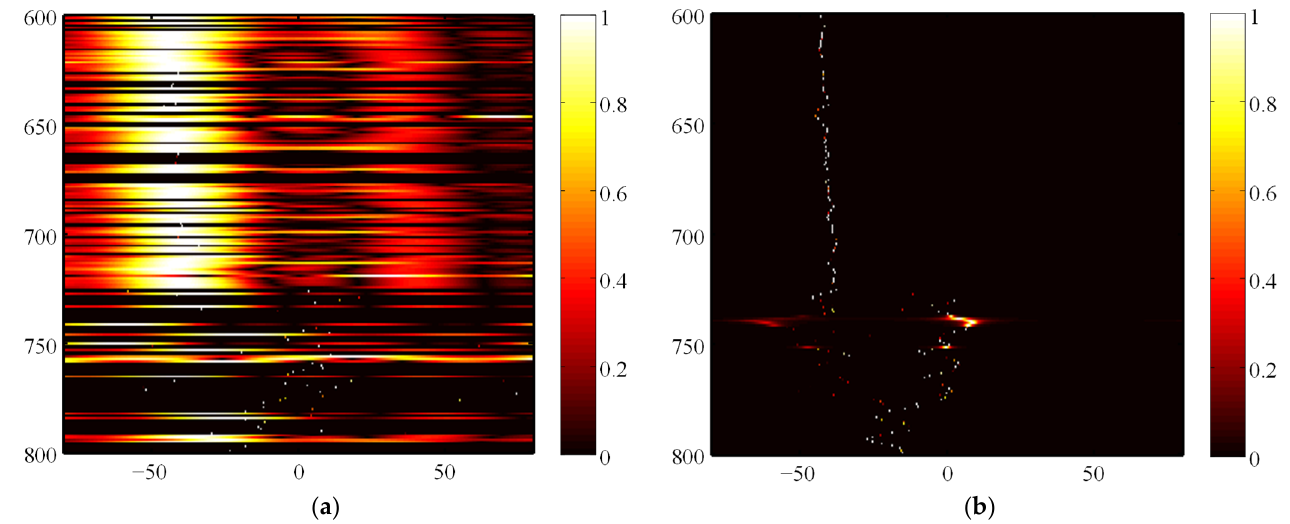
Figure 5. Normalized amplitude diagram. ( a ) Traditional L1 norm compressive sensing method; ( b ) Multi-look compressive sensing method. The horizontal axes are heights in the elevation direction with the unit m, and vertical axes represent pixels from 600 to 800 in the slant range.